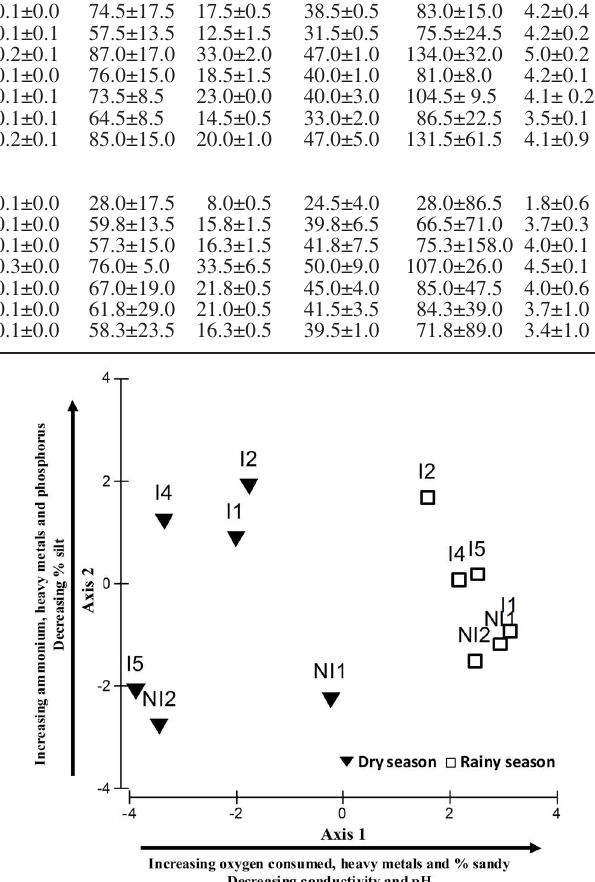
Fig . 2. – Principal components analysis (PCA) biplot for the water and sediment variables, the sites and seasons sampled are indicated. The first and second axes explained 51 % and 17% of the variation, respectively. NI, non-impacted sites; I, impacted